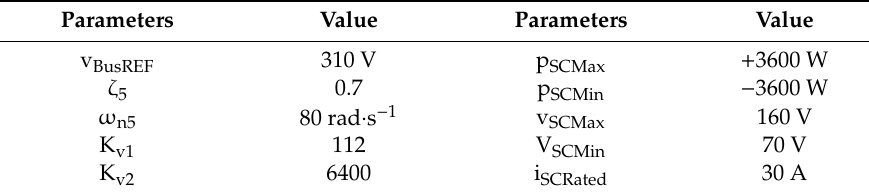
Table 3. DC link energy regulation parameters.